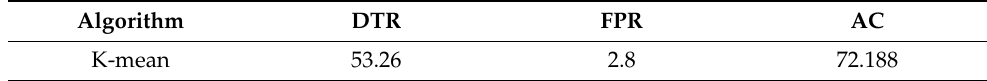
Table 7. Measurement of K-mean parameters.